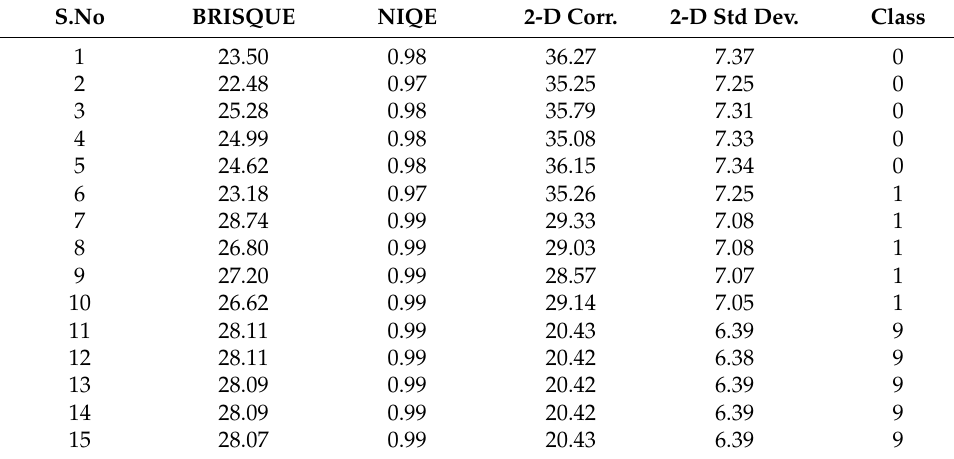
Table 4. Sample features selected using HTS